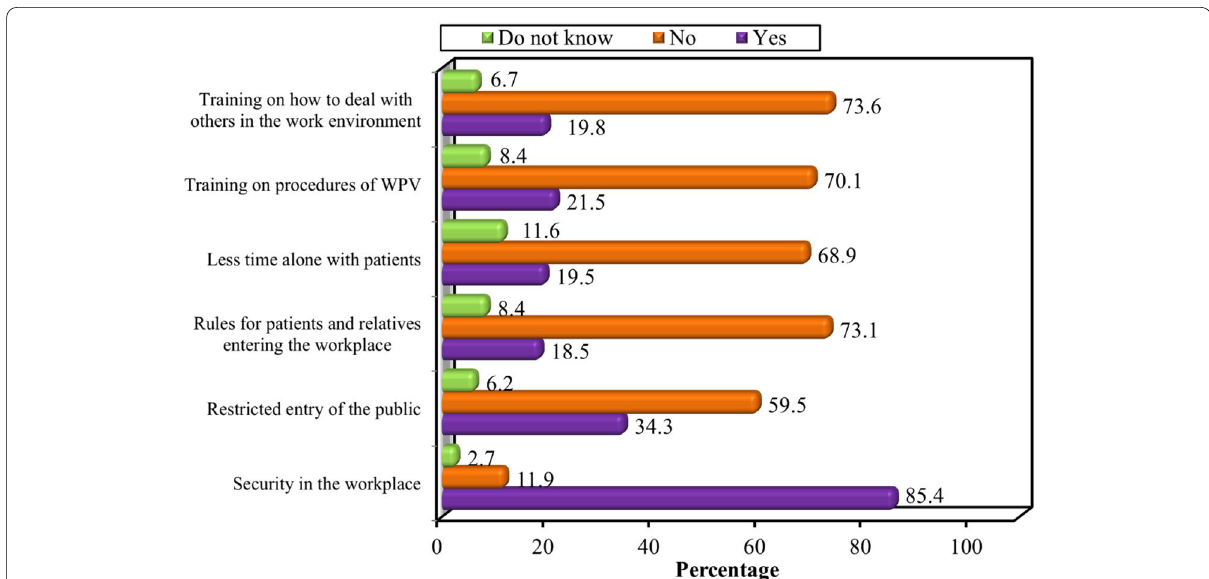
Fig. 3 Opinion of the studied healthcare workers about workplace characteristics that can prevent exposure to violent events during COVID‑19 pandemic